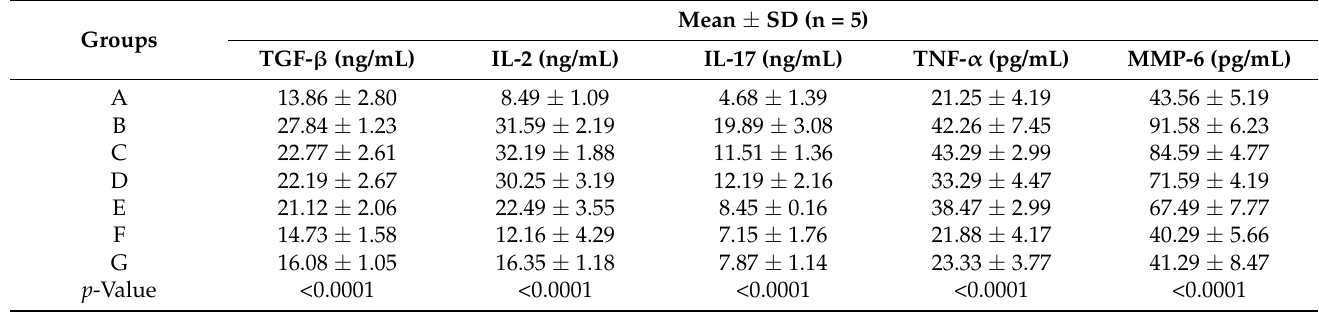
Table 2. Inflammatory Markers Profile Of LPS Induced Multiple Sclerotic Wistar Rats.